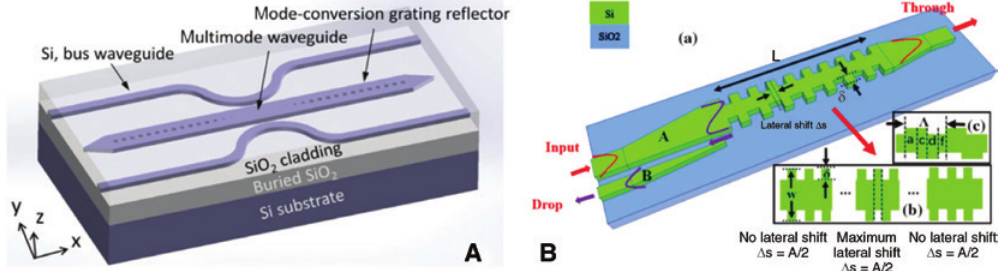
Figure 17: On-chip add-drop optical filters with higher-order modes. (A) An on-chip add-drop filter based on a multimode Fabry-Perot cavity [190]. (B) An on-chip add-drop filter based on a multimode Bragg grating